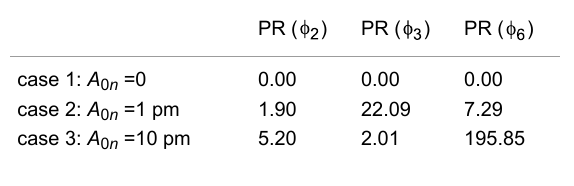
Table 3: The phase ratio for a given harmonic phase shift n , PR( ), as defined by Equation 20 when 1) no higher harmonic external drives are allowed ( A 0 n = 0) and when external drives lead to 2) A 0 n = 1 pm and 3) A 0 n = 10